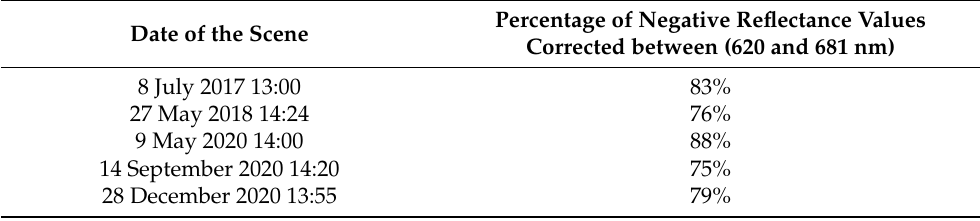
Table 1. Percentage of negative reflectance values corrected between (620 and 681 nm) by using POLYMER ext on Sargassum- dominated